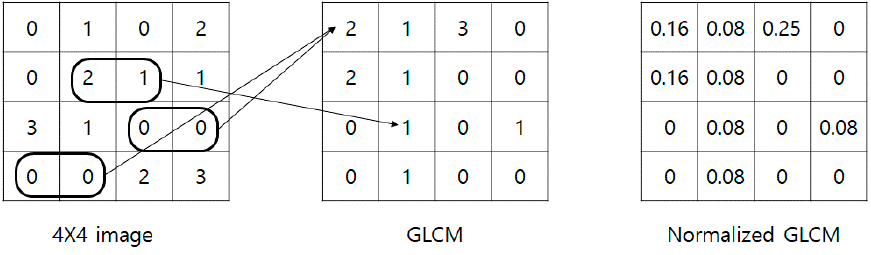
Figure 1. Process of generating a gray level co-occurrence matrix (GLCM).